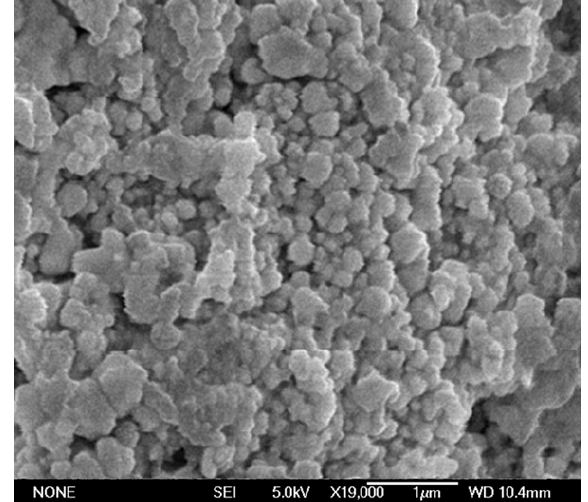
Figure 3. SEM image of PGDIL–TiO 2 powder.